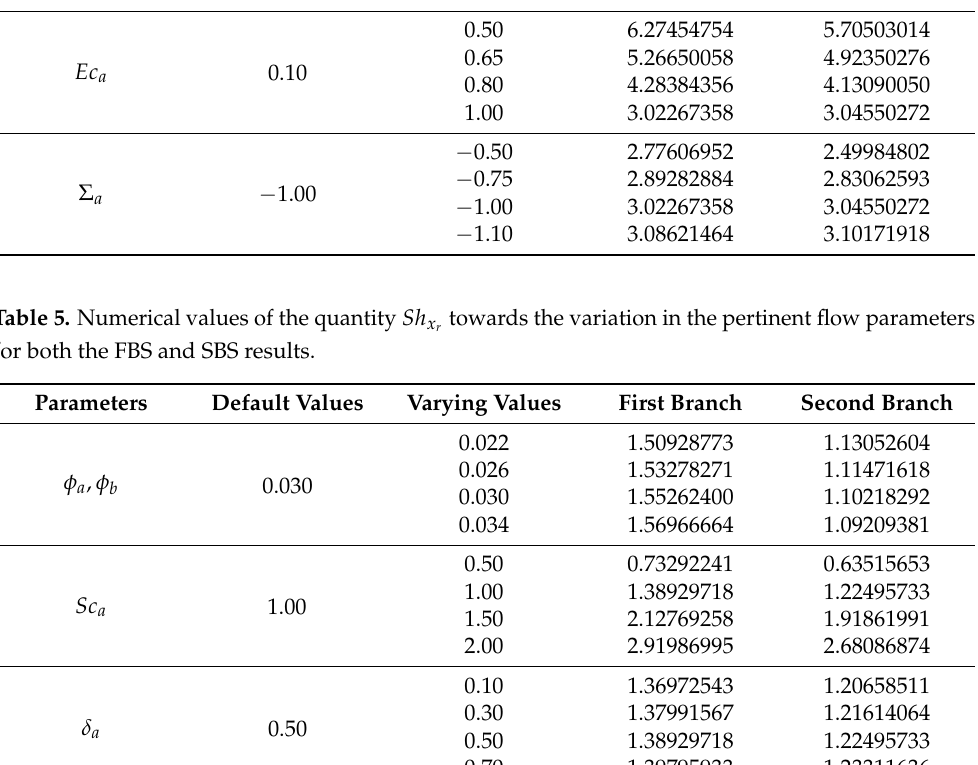
towards the variation in the pertinent flow parameters r